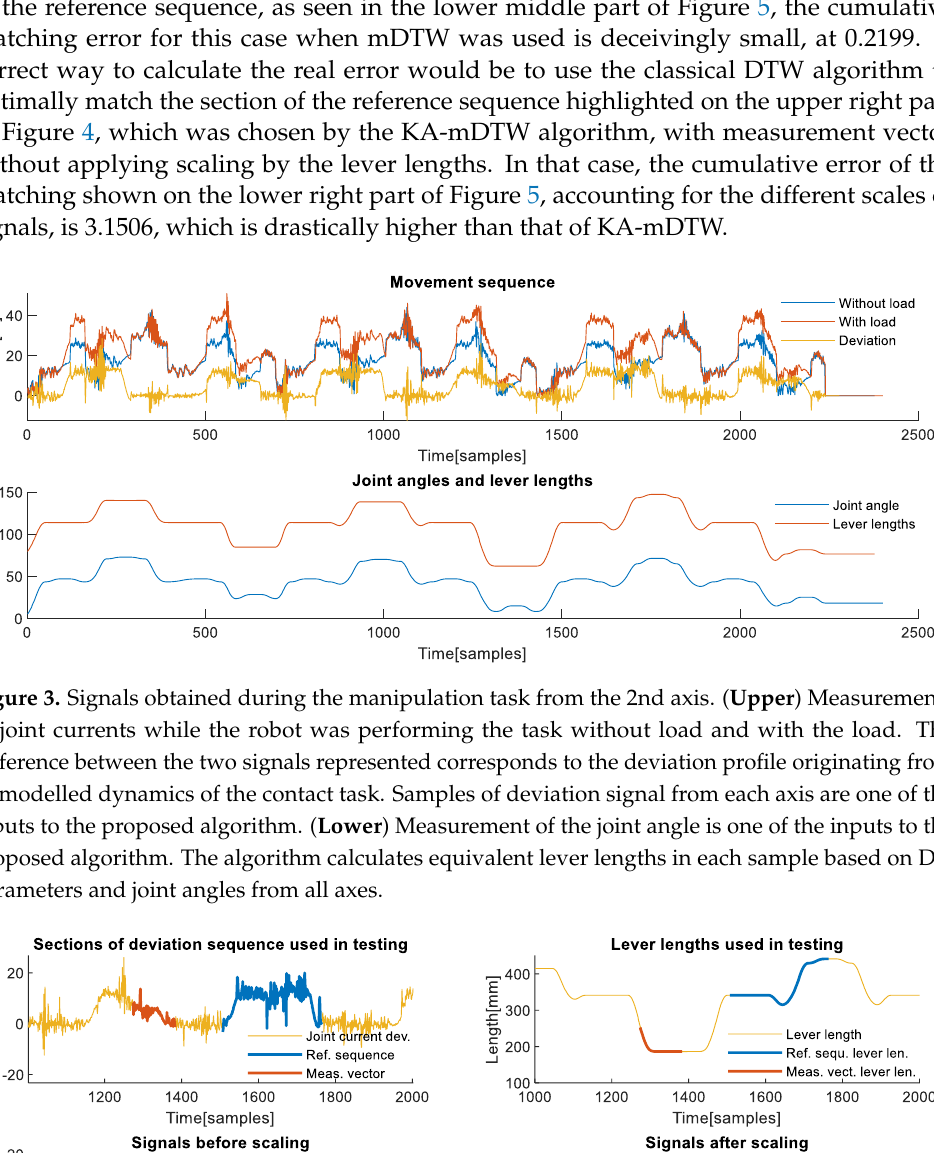
10 of 19 Figure 2. Measurement setups. ( left ) Load manipulation contact task. ( right ) Snap-fit assembly con- tact task. 4.1. Consistent Base Frame Direction of Force Following the general description of tasks within this category and relevant case of lever length calculations, this section aims to illustrate the inclusion and interpretation of contact task forces with consistent direction in the robo t’s base frame while performing a representative task example. Load manipulation is one of the typical tasks from this cate- gory and perhaps the most intuitive to understand, since gravity is universally familiar. To emulate possession of the optimal robot model, the first sequence of the move- ment was made without the presence of the load. The measurement from this movement represents an optimal model of the robot in which load dynamics are not included. The second sequence was recorded with actual load in a task where the robot simulates ma- nipulation, in which the picking position is constant while placing positions differ one from the other. The first four placing positions feature identical orientations of the tool but with different distances from the base of the robot. The last two placing positions have identical tool orientations between them but differ compared to the first four and differ from each other in distances from the robot’s base. Absolute values of joint currents were used in the manipulation contact task, together with joint angles, to complete the meas- urement vector.